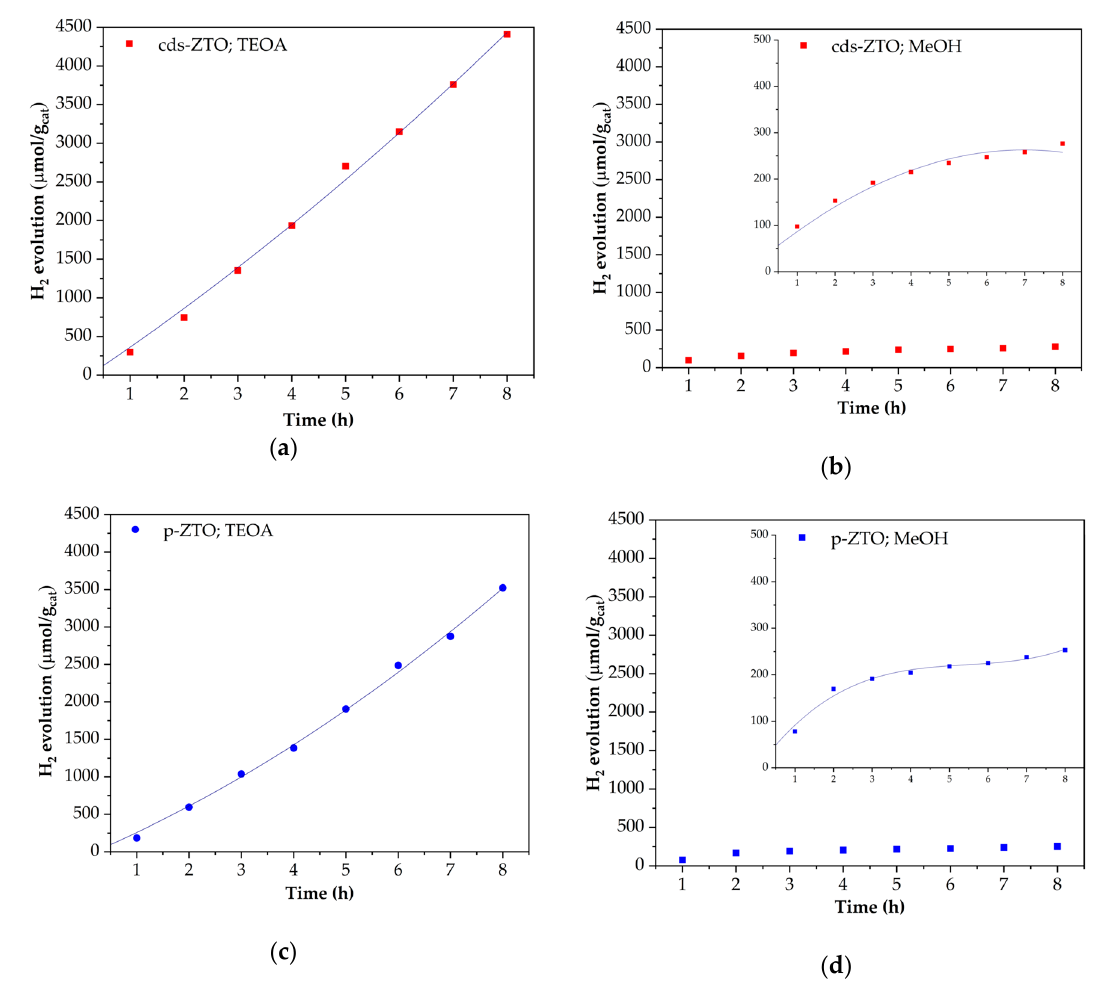
Figure 13. Photocatalytic evaluation of cds-ZTO ( a , b ) and p-ZTO ( c , d ) for hydrogen production using triethanolamine and methanol as sacrificial agents, respectively.